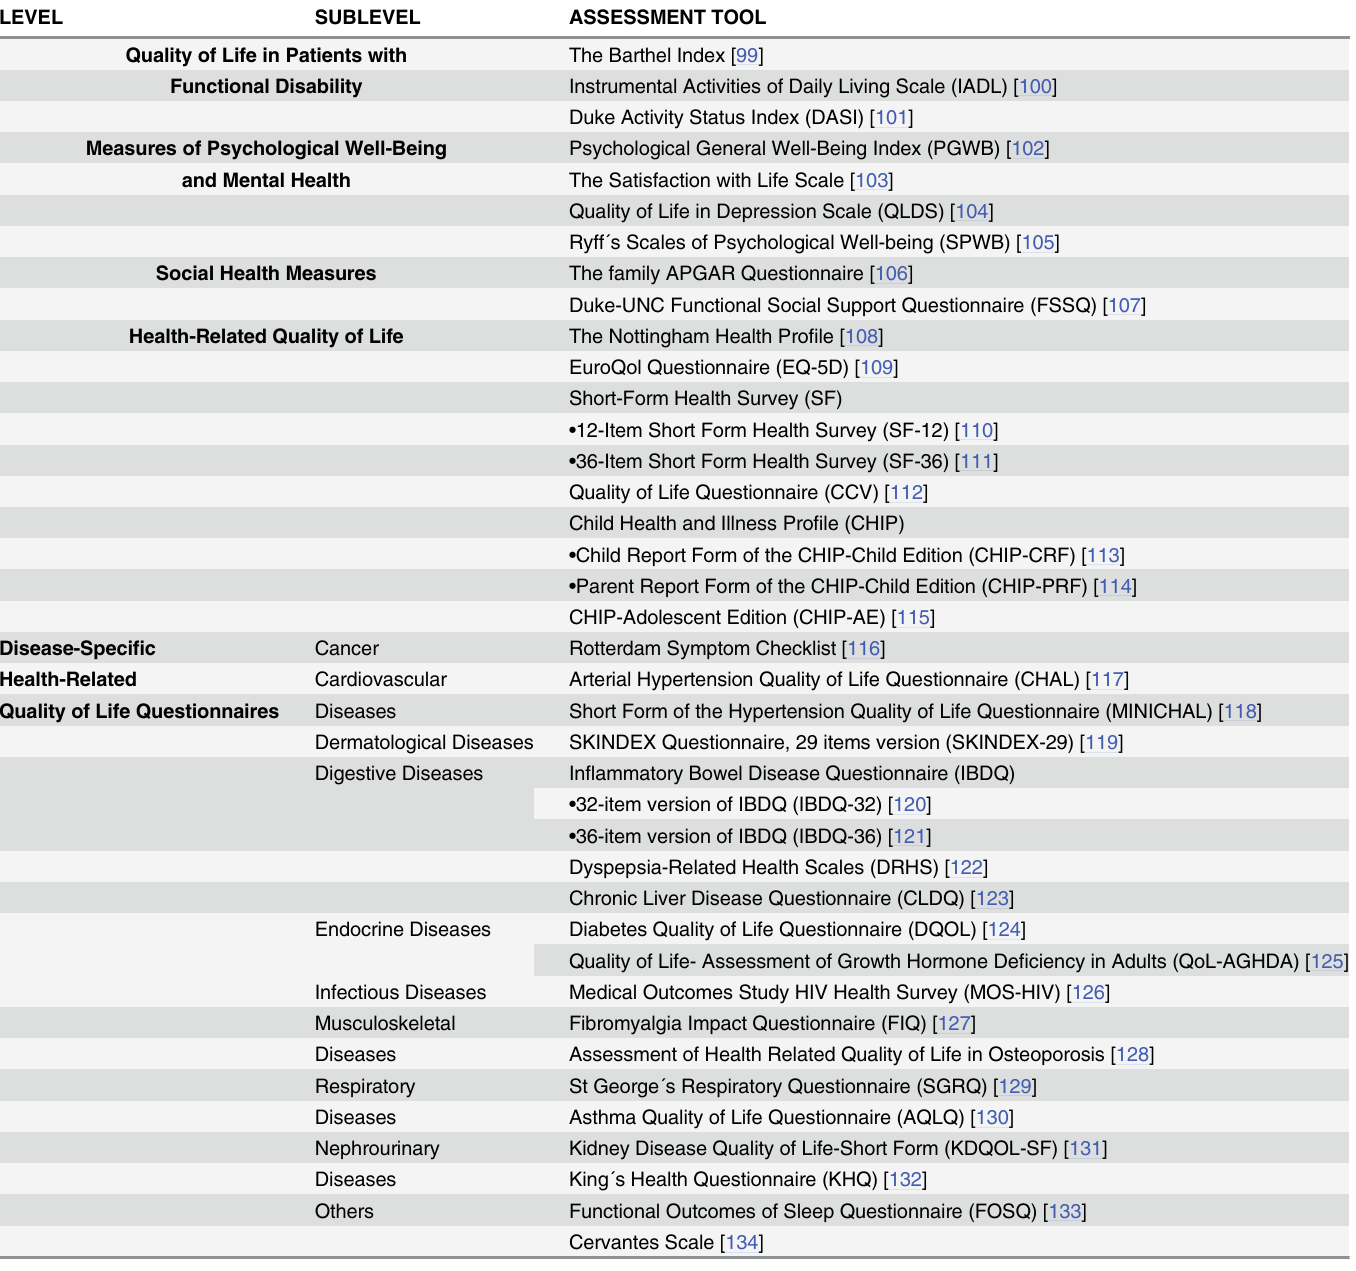
Table 3. Assessment tools of the module of Quality of